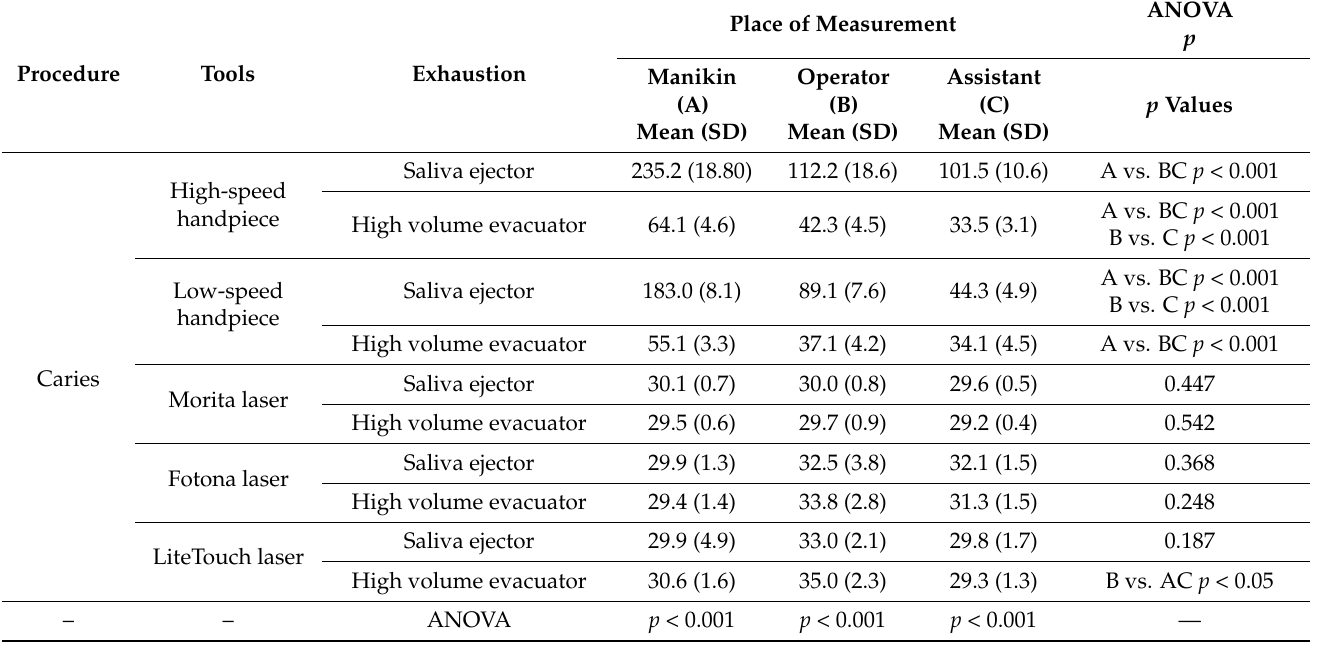
Table 2. The level of aerosol particles ( × 103) measured at the manikin’s, operator’s, and assistant’s mouths (Mean (SD)) during tooth/caries’ preparation.